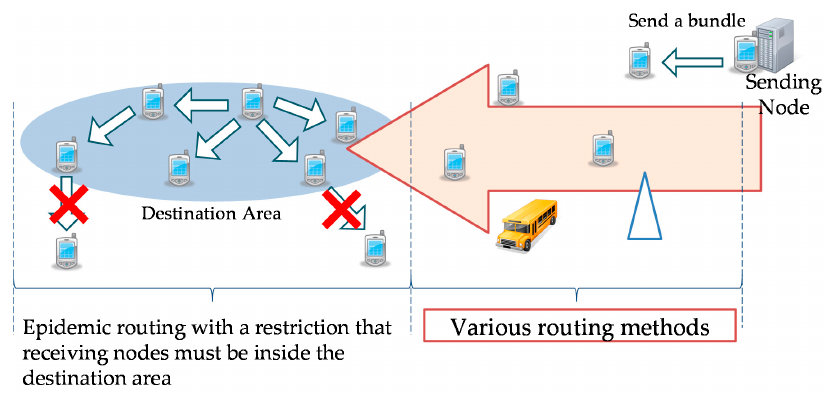
Figure 20. Application conditions for existing routing methods.